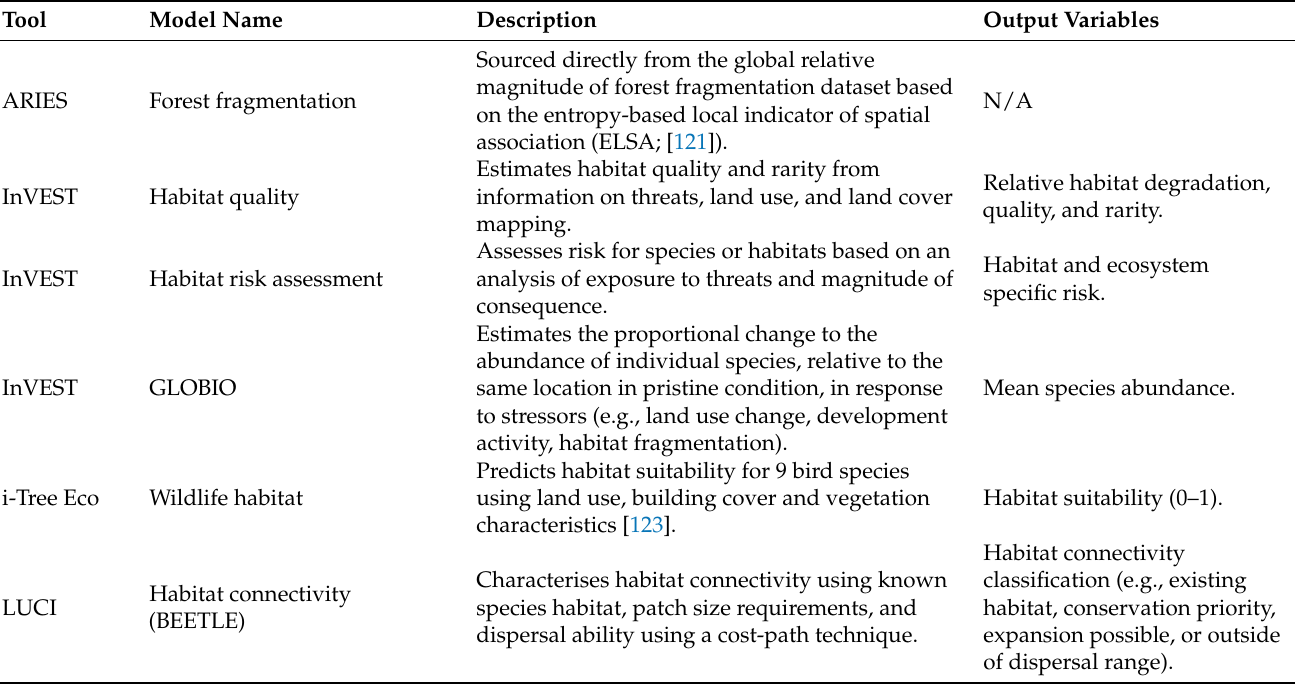
Table 7. Summary of the shortlisted tools and associated models that quantify measures of